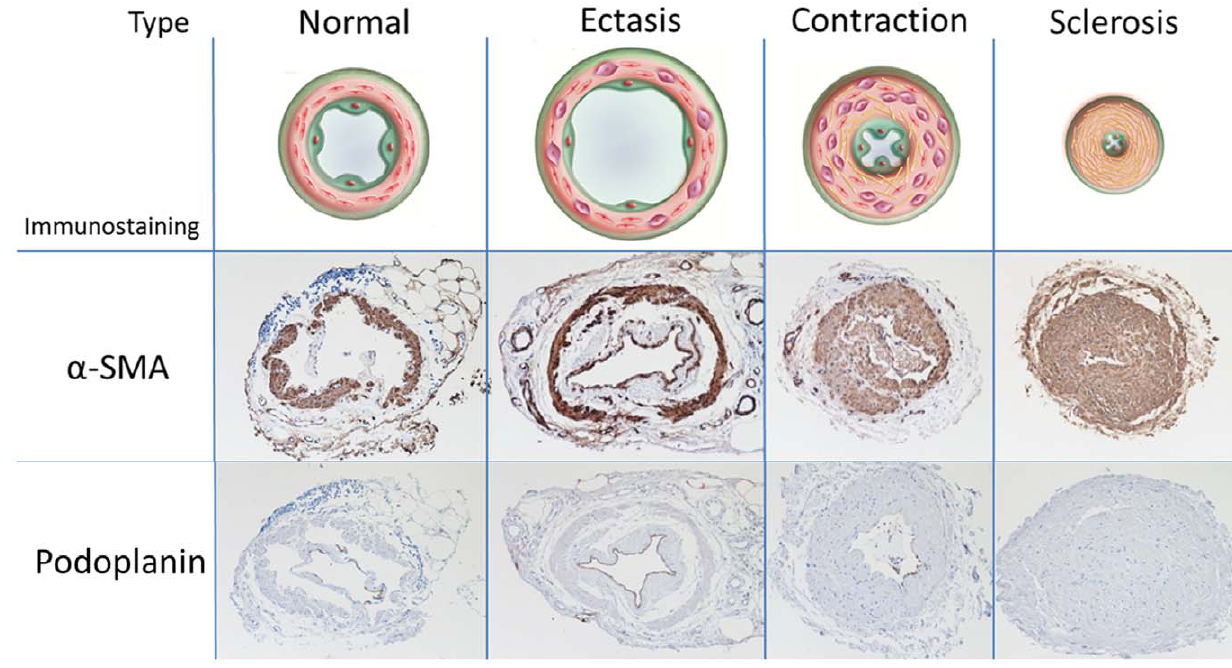
Figure 3. Classification of the types of collecting lymphatic vessels and the corresponding immunostaining findings. The first row: Findings from alpha- smooth muscle actin ( a SMA) staining. In the normal type, several layers of smooth muscle cells were present. In the ectasis type, the smooth muscle cell layer was moderately thin. In the contraction type, a very thick layer of smooth muscle was present directly beneath the endothelium, and the lumen was narrowed to a certain degree. In the sclerosis type, the lumens were narrowed. The second row: Findings from podoplanin staining. The normal type was positive for podoplanin staining in the endothelium; the ectasis type was strongly positive; the contraction type, slightly positive; the sclerosis type, negative.